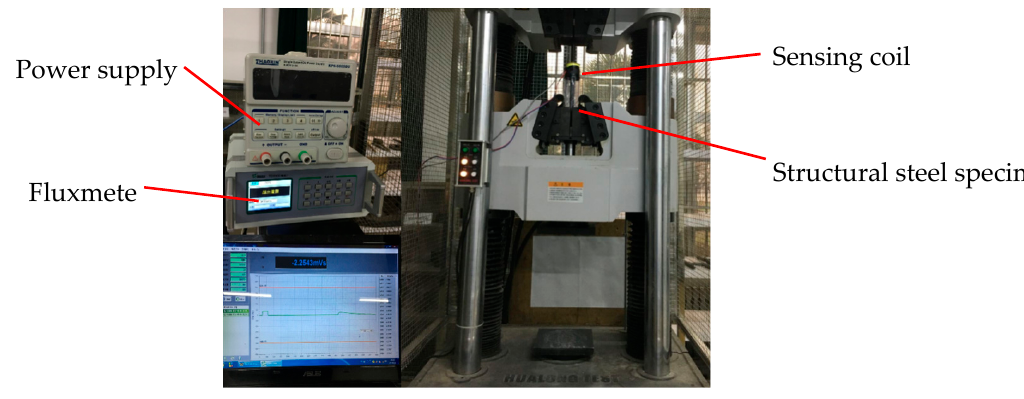
Figure 7. Effect testing of Tensile Force on Magnetic Flux. Figure 7. E ff ect testing of Tensile Force on Magnetic